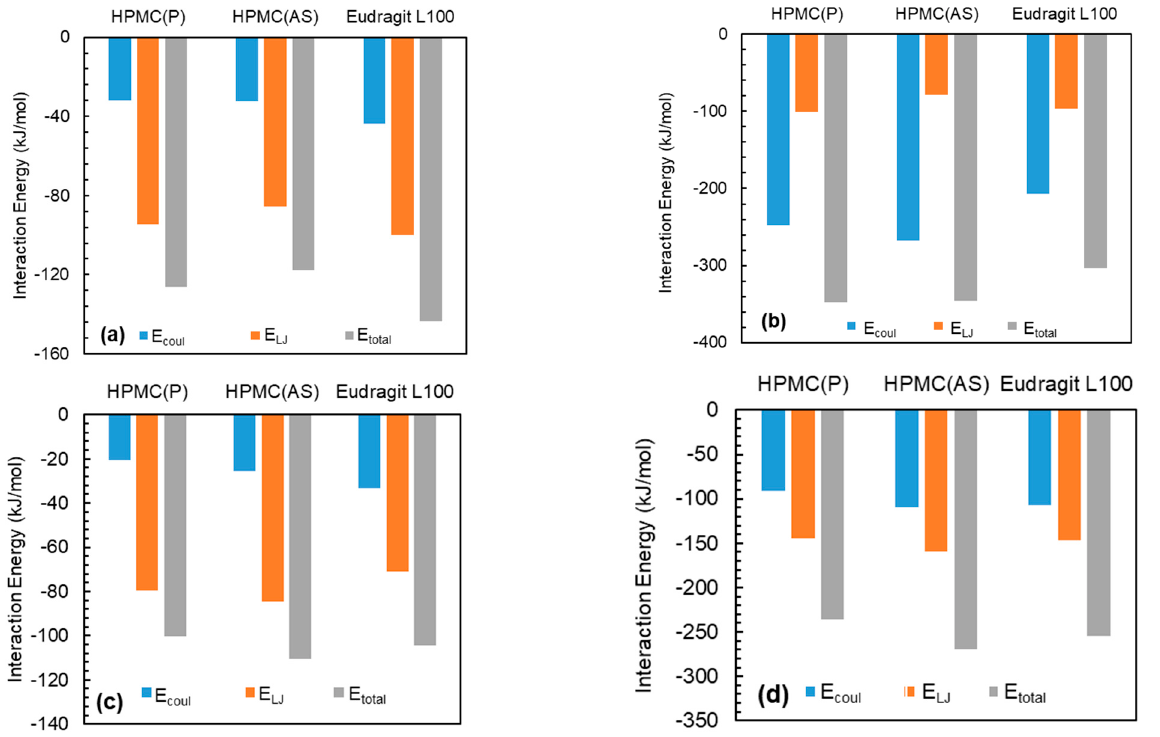
Figure 4. Interaction energies in terms of electrostatic (E coul ), Lenard–Jones (E LJ ), and total (E total ) between API molecules and polymer excipients for ( a ) NPX, ( b ) NaDLO, ( c ) DMF, and ( d )